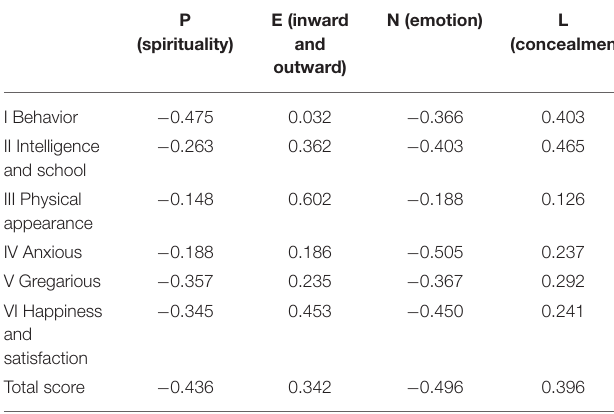
TABLE 4 | EPQ scores of children in the children’s village and comparison with s ). national norm ( x ±